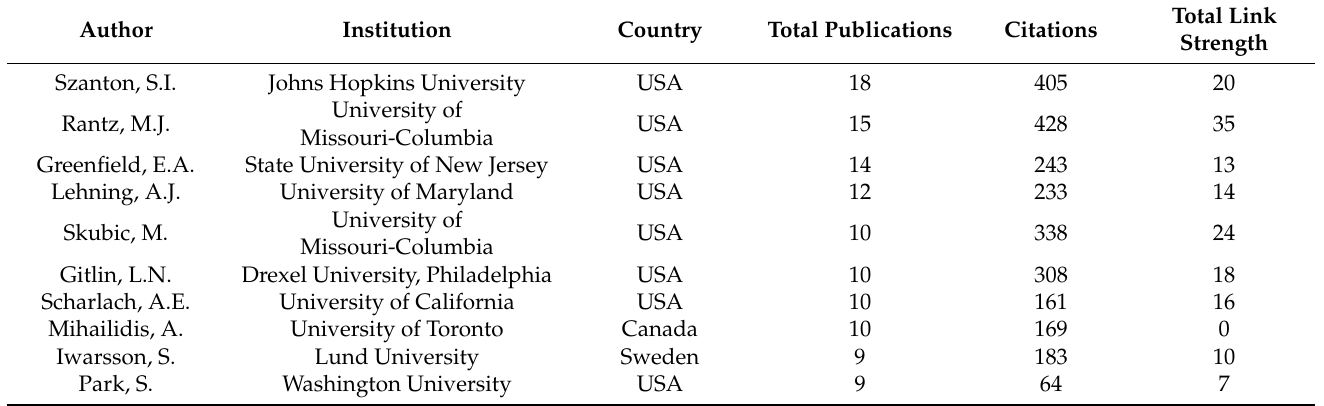
Table 1. The top 10 most productive